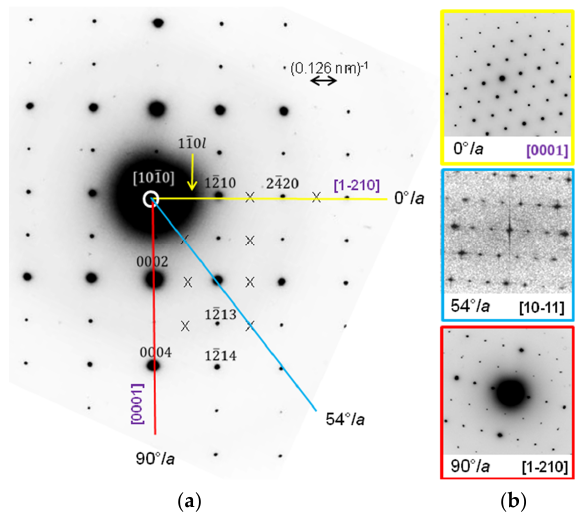
Figure 4. ( a ) Electron diffraction pattern of a human tooth enamel crystal along the [10-10] axis. It was indexed with the hexagonal hydroxyapatite (HAP) unit cell. ( b ) The [1000], [10-11], and [1-210] diffraction patterns, which are perpendicular to the [10-10] axis. The color of the line indicates the zone axis of the diffraction pattern of the squares with the same color.